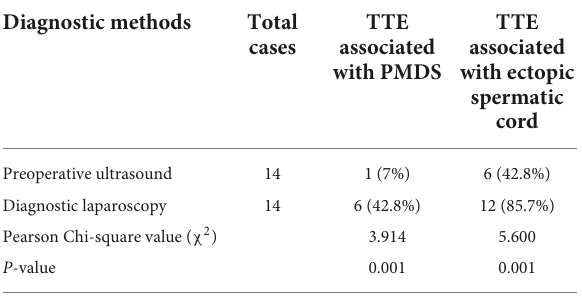
TABLE 2 Comparison of diagnostic accuracy of preoperative ultrasound and diagnostic laparoscopy in children with